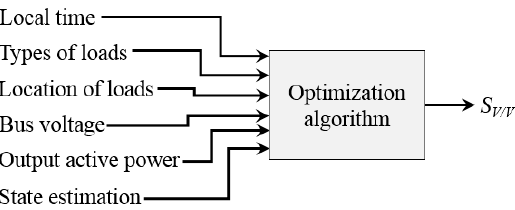
Figure 8. Decision-making process of S V/V .